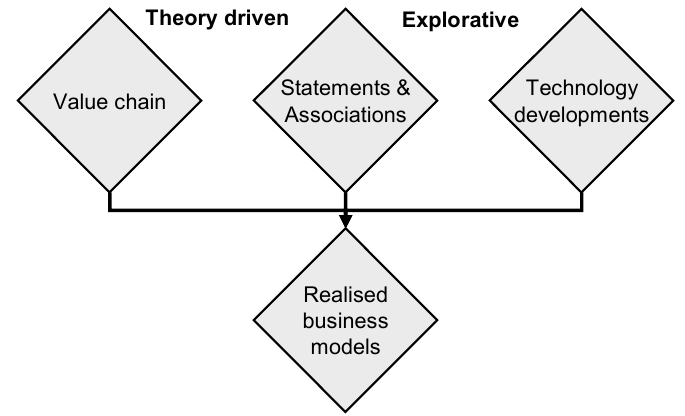
Figure 4. Approach of the practice-based analysis.